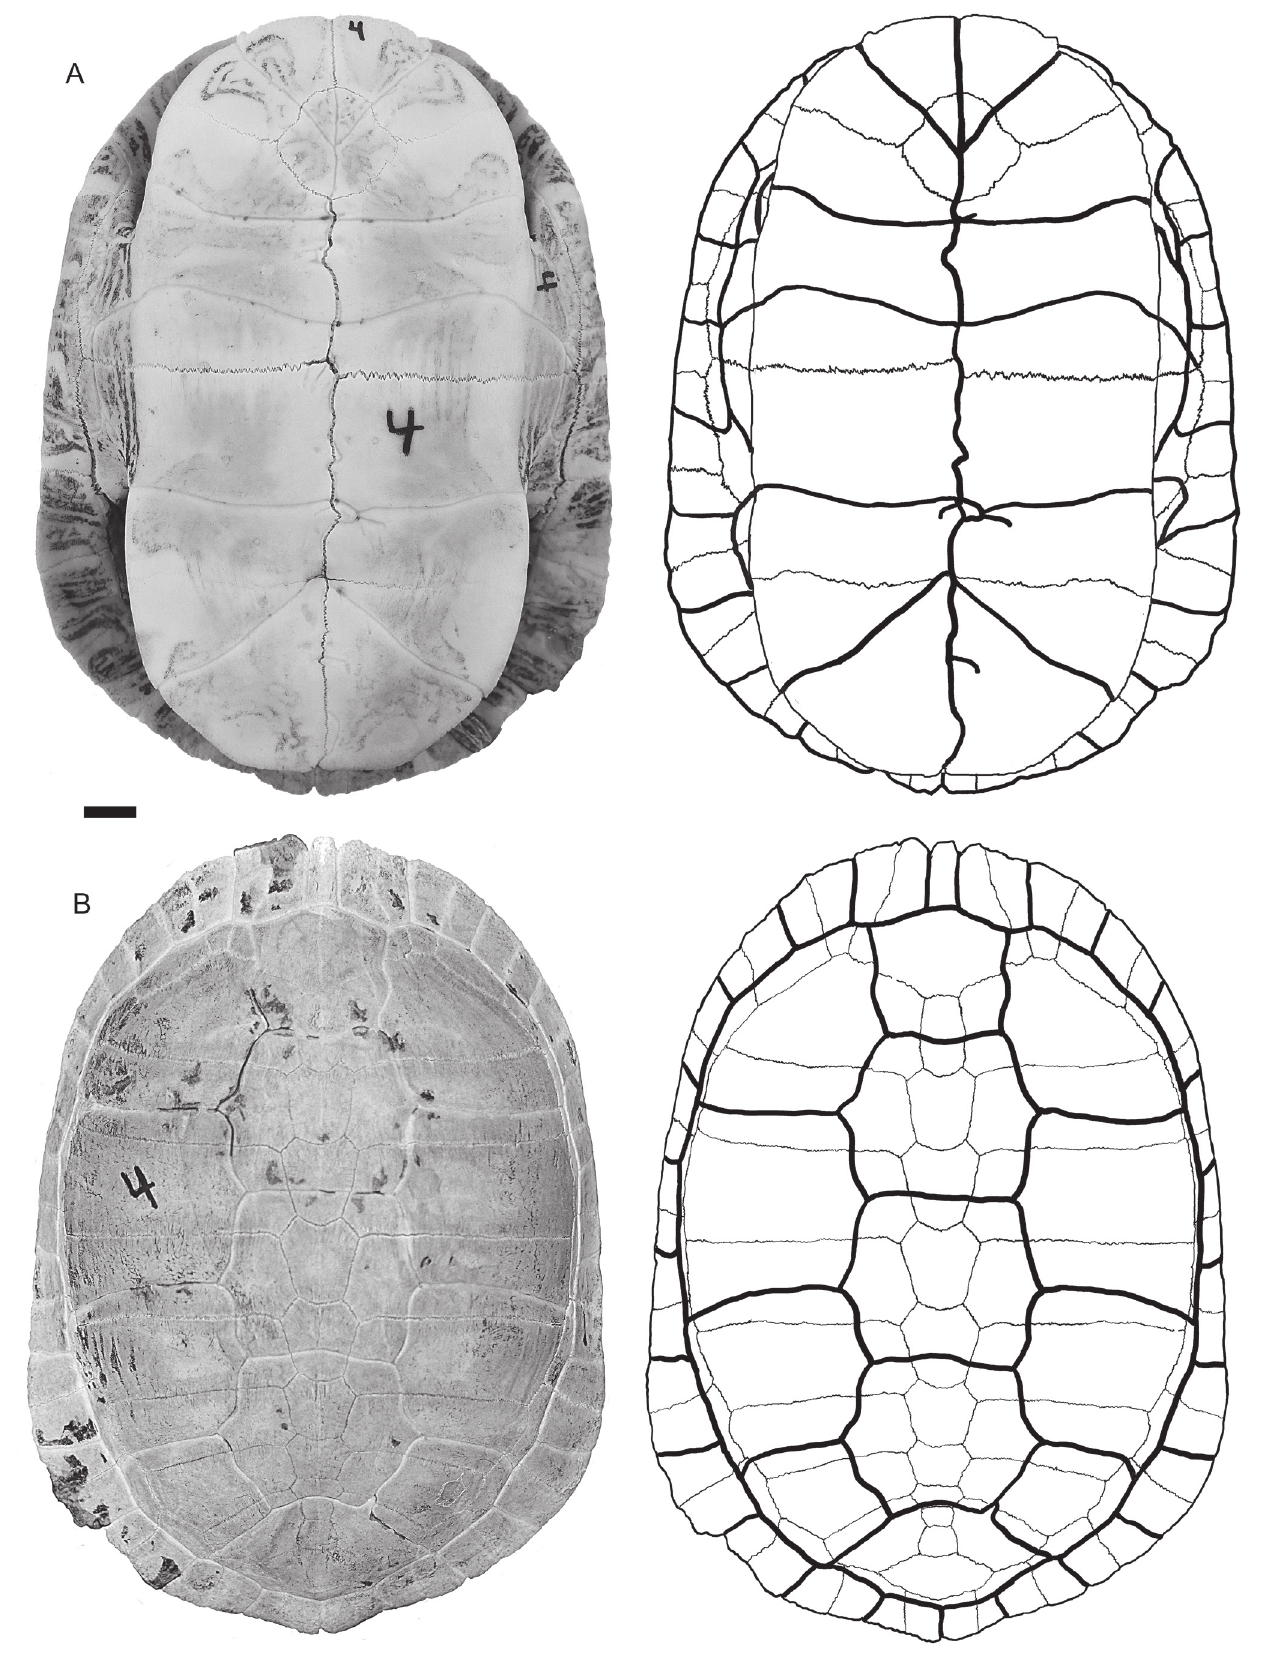
Figure 2. Chrysemys picta bellii , Neb 4. A, plastron and B, carapace. Scale bar = 1